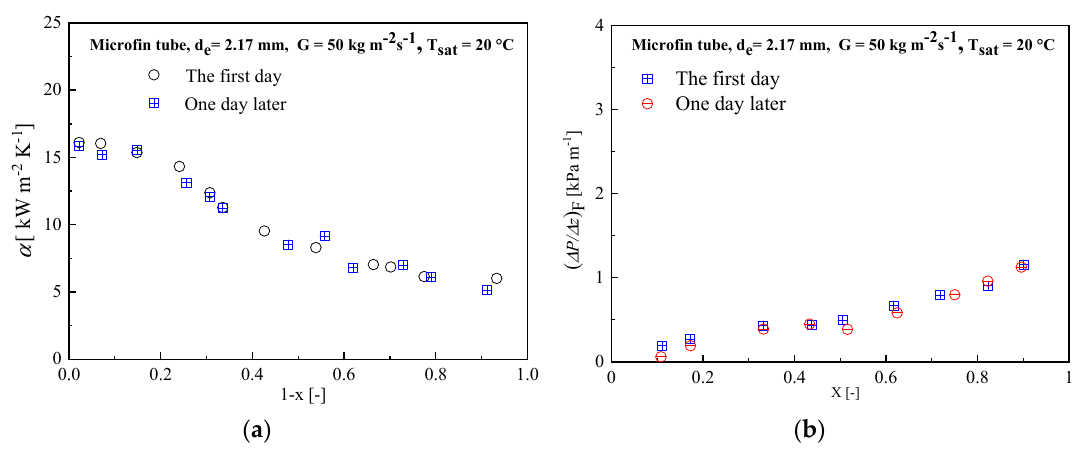
Figure 4. Repeatability of experiment: ( a ) heat transfer; and ( b ) pressure drop.